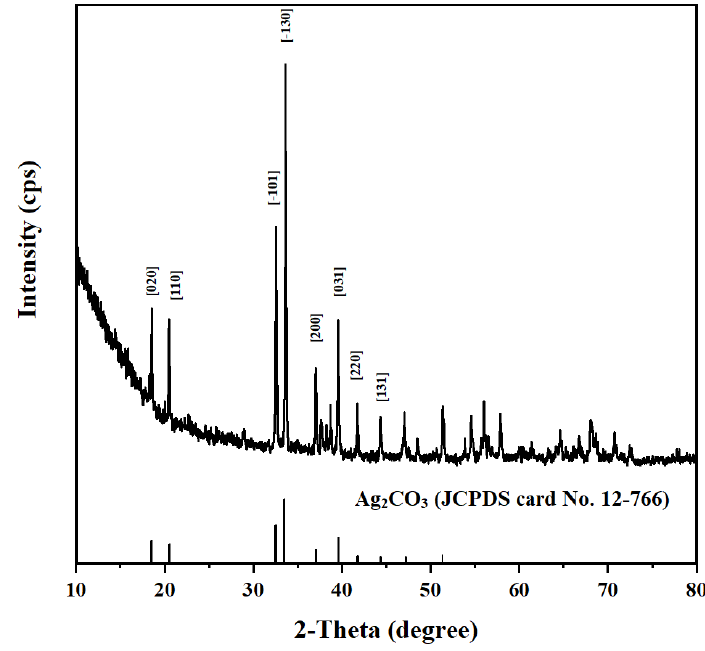
Figure 1. XRD pattern of Ag 2 CO 3 .